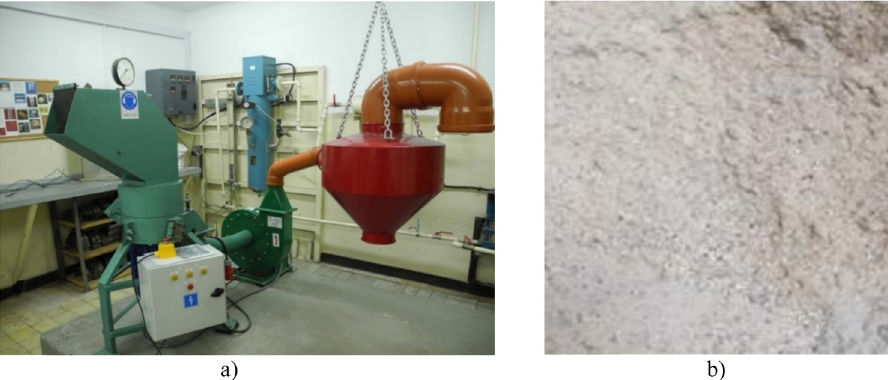
Figure 1: ( a ) Crusher – a stand for processing composite materials and ( b ) view of polyester – glass granules with the grain size ≤ 1.2 mm [ 6,8 ] .